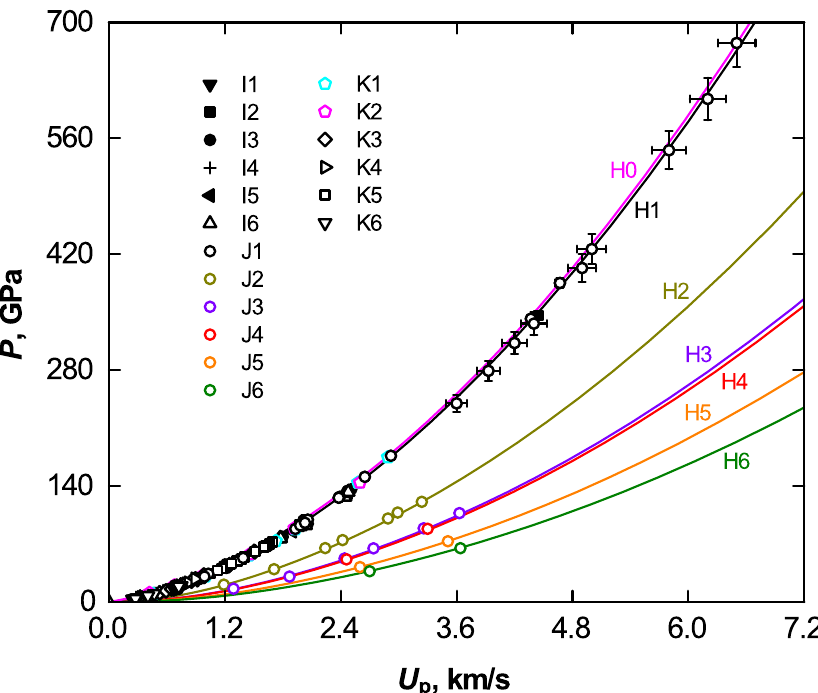
Figure 3. Shock adiabats of bismuth samples of different initial densities and initial temperatures at an initial normal pressure; designations are the same as in Figure 2.